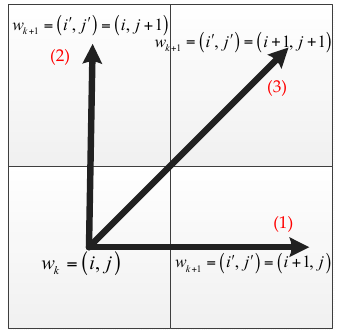
Figure 2. Potential searching directions.